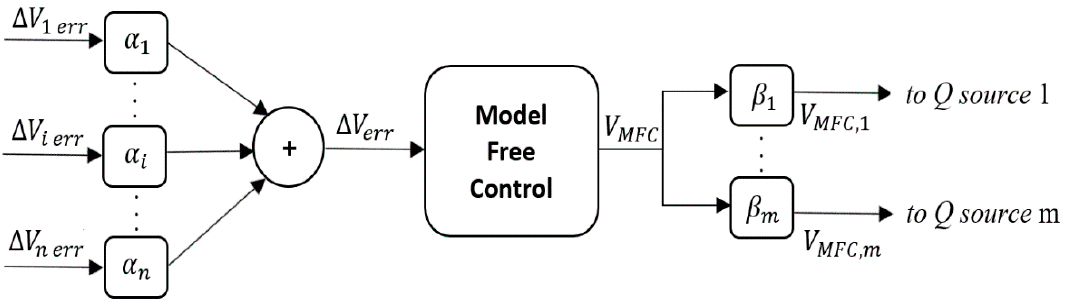
Figure 3. Voltage magnitudes of all buses in the IEEE 21-bus microgrid system under normal operating condition.